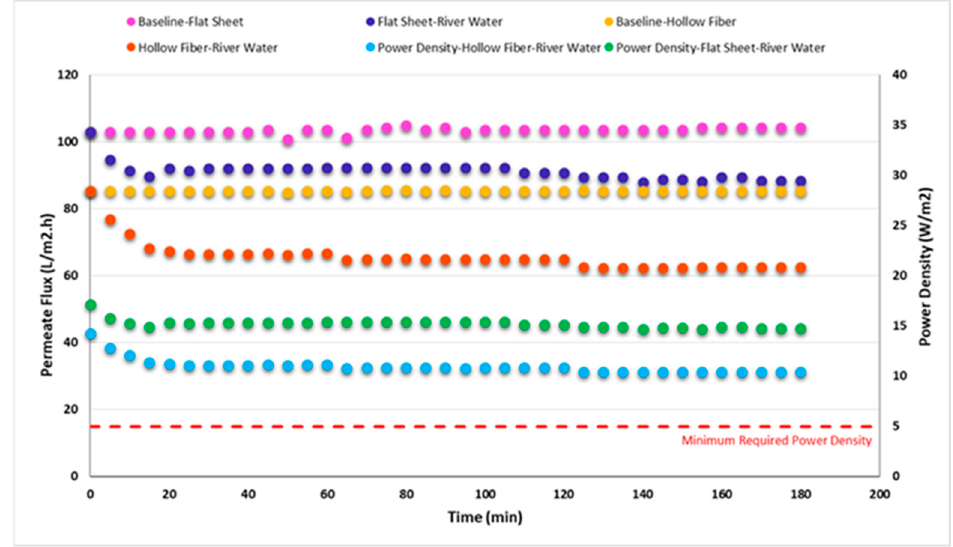
Figure 9. Impact of fouling on permeate flux and power density for two diverse membrane modules.